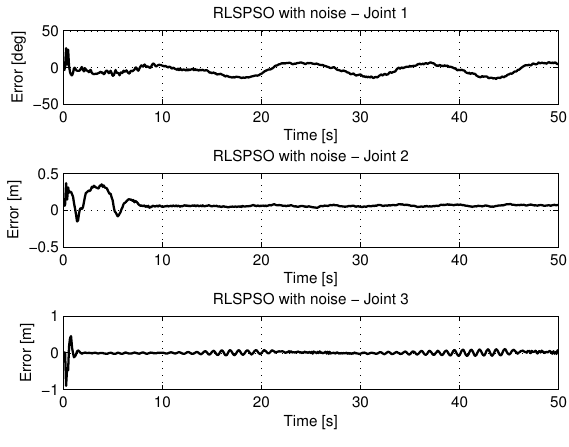
Figure 34. Error of Trajectories identifications with RLSPSO with noise.